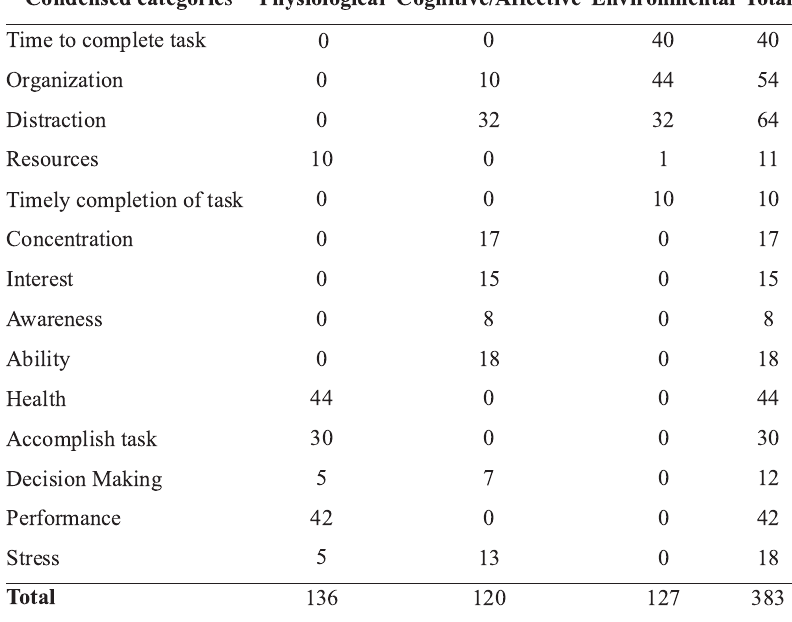
Frequency ofcondensed categories by